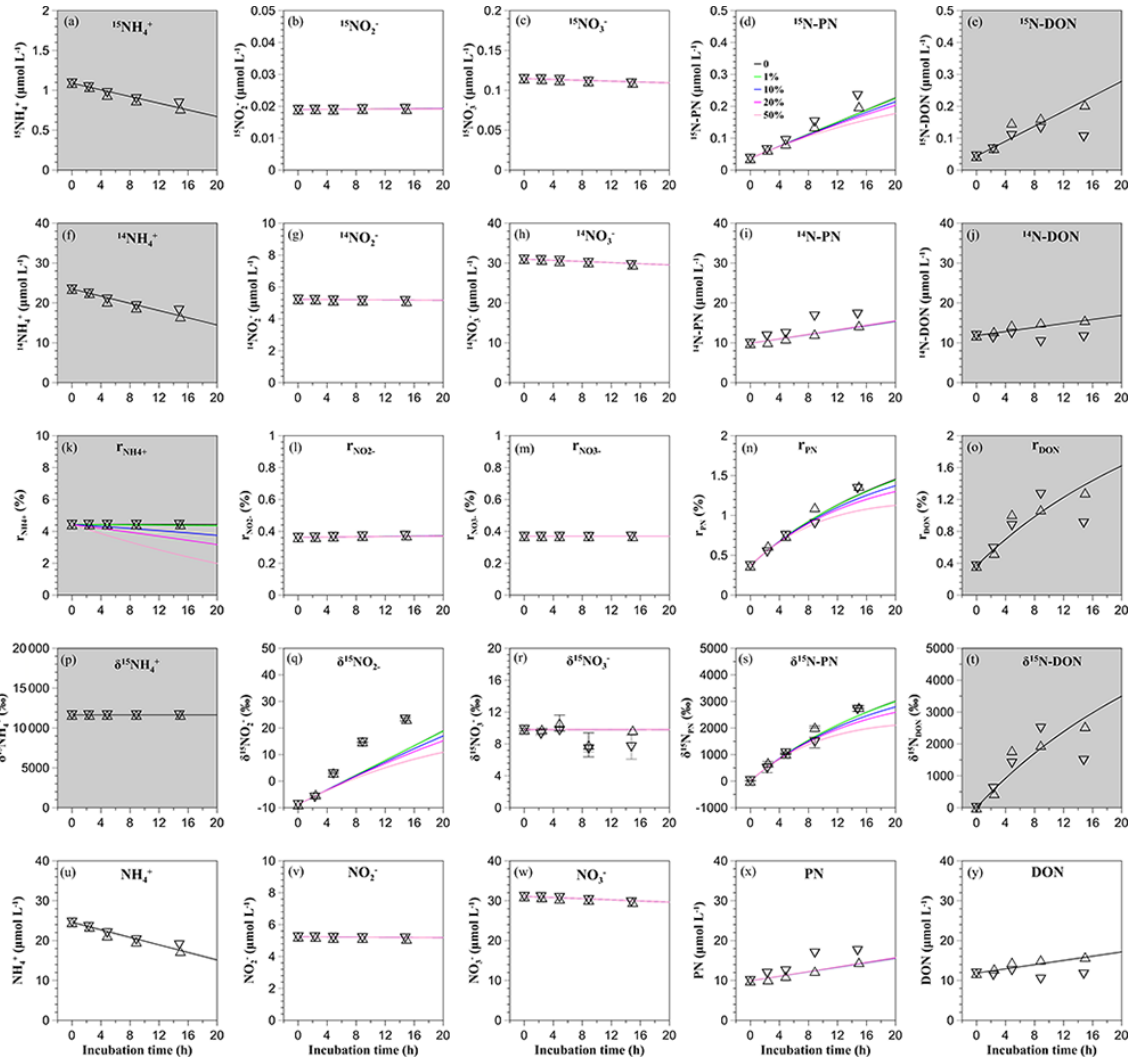
Figure 5. The observed and STELLA-derived values in the high-nutrient case: in the first part 80% sPAR depth and in the second part 2% sPAR depth for (a) [ 15 NH + (i) [ 14 N-PN], (j) [ 14 N-DON], (k) r PN, (t) δ 15 N-DON, (u) [NH + the duplicate observational values; the black, green, blue, magenta, and pink solid lines represent the STELLA model simulations of r decreases 0, 1, 10, 20, and 50% in 15h,